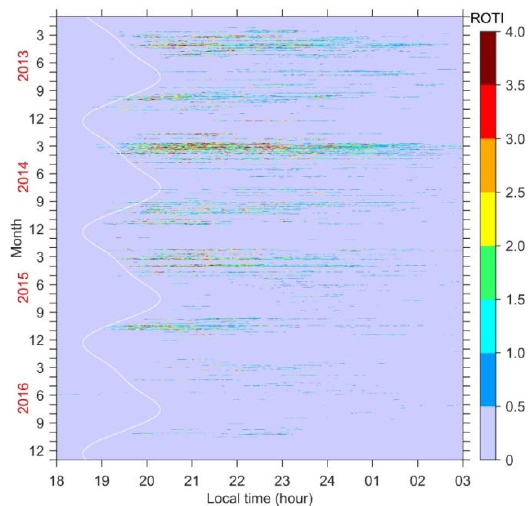
Figure 2. Climatology characteristic of ionospheric scintillation in Hong Kong during 2013–16. The white line represents the local sunset time at 350 km altitudes. The white line represents the local sunset time at 350 km